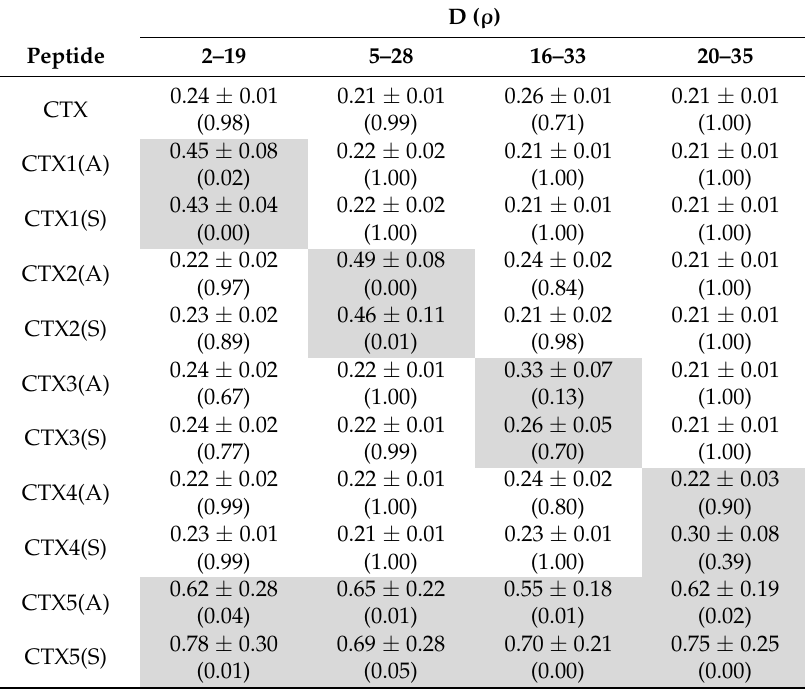
Table 3. The C β H β 1,2 –C β H β 1,2 center-of-mass distances (D) in nm (mean ± SD) between residue pairs for CTX and its Abu- and Ser-substituted analogs given in nm. Probabilities ( ρ ) of contact ≤ 0.26 nm are in parenthesis. The Abu- and Ser-substituted residues are highlighted with grey background